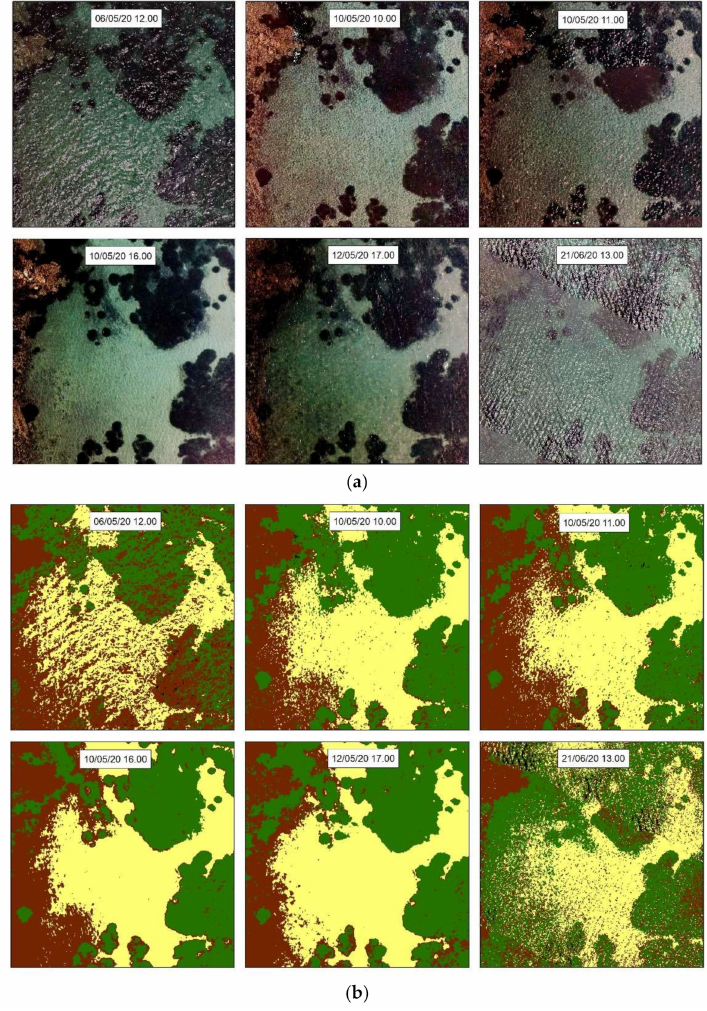
Figure 4. ( a ) Subsets of the orthophoto-maps in chronological order of acquisition times, from top left to bottom right. ( b ) Subsets of the classified images in three classes: seagrass in green colour, sand in yellow, mixed substrate in